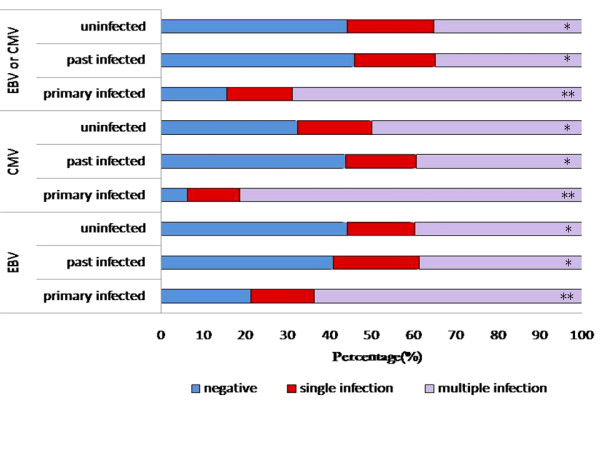
Coinfection of EBV or CMV and other pathogens. Between * and ** the p value < 0.01.